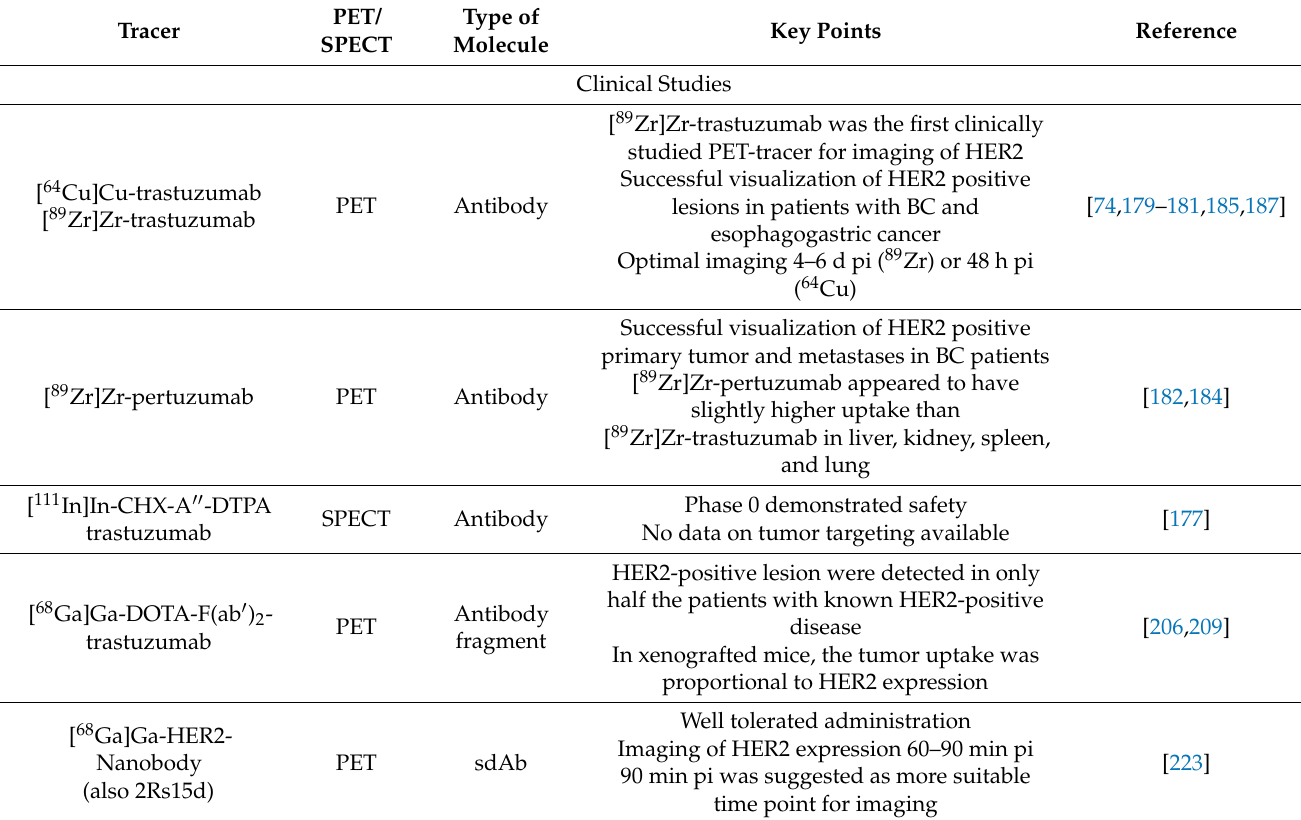
Table 2. Overview of the tracers undergoing clinical trials for PET and SPECT imaging of HER2 expression and most promising tracer under preclinical development. Tracer Key Points Reference Clinical